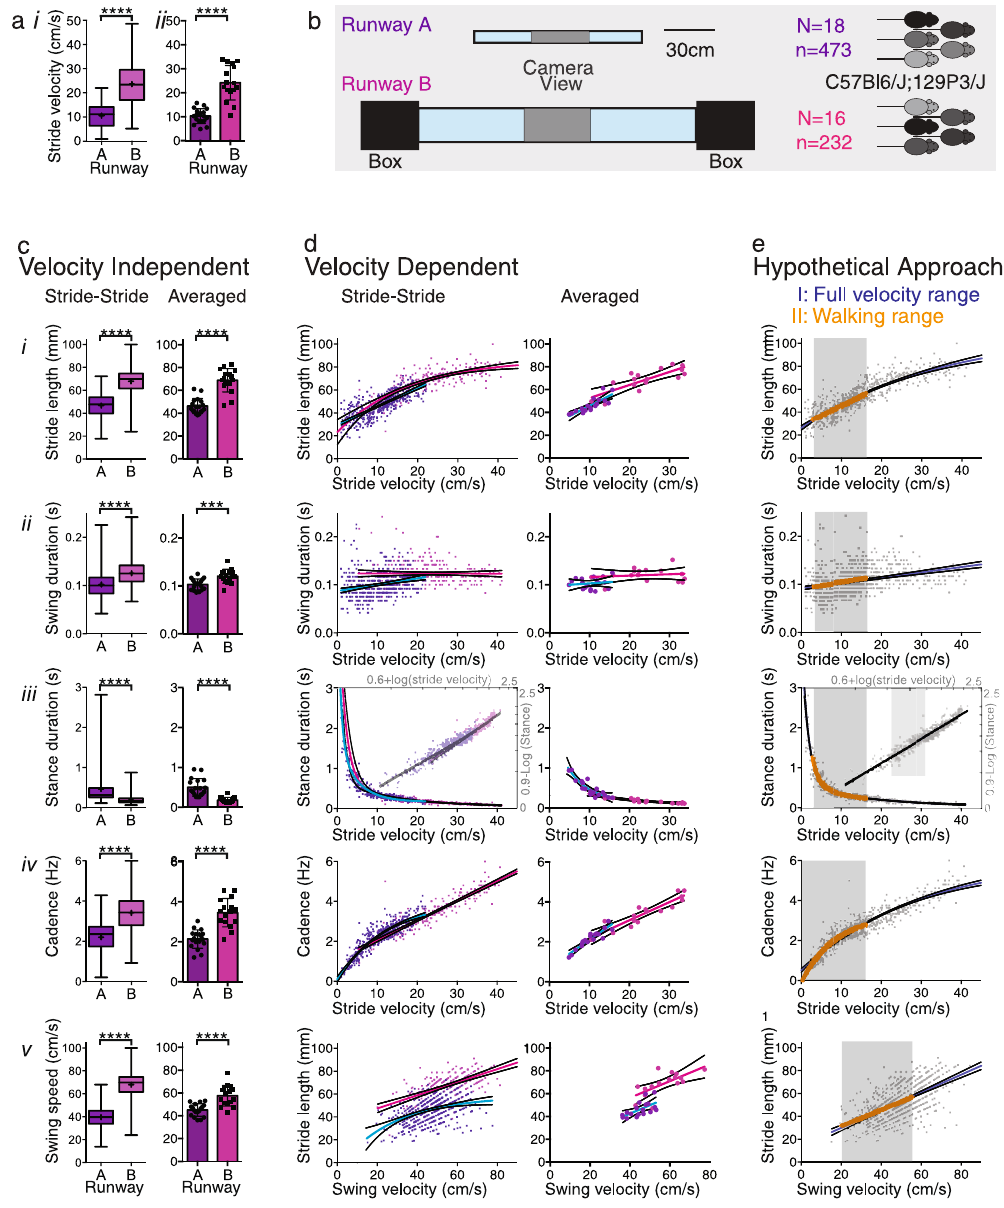
Figure 1. Visualization of spatial and temporal gait parameters. ( a ) Box and whisker plots ( i ) showing the distribution and comparisons of stride-to-stride velocity data collected on Runways A and B (Mann Whitney Rank test; center representing median, center cross representing mean, bars representing minimum and maximum), and ( ii ) bar graphs with scatter plots of average stride velocity (2-tailed t-test; error bars indicate standard deviation). ( b ) Schematic representation of the dimensions of runways A and B. Video recordings covered the middle portion (gray shaded area). ( c ) Stride length ( i ), swing duration ( ii ), stance duration ( iii ), cadence ( iv ) and swing speed ( iv ) represented as stride-to-stride data in box and whisker plots and as averaged data in bar graphs with scatter plots. See Supplementary Table S3 for statistical test results. ( d ) Visualization of gait parameters plotted as a function of stride velocity. Each of the parameters behaves differently as a function of velocity, as illustrated by best fit non-linear regression curves (colored lines) and 95% confidence bands (black lines). Panel iii contains a log transformation of the stance data (opaque). ( e ) Example of how regression models capture stride-to-stride data of the full velocity range versus walking range (gray